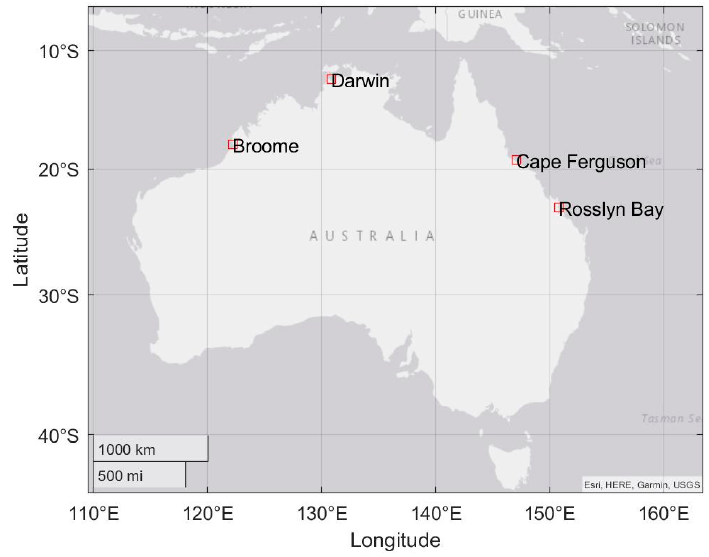
Figure 1. The location of tide gauges (red squares) used for this study.